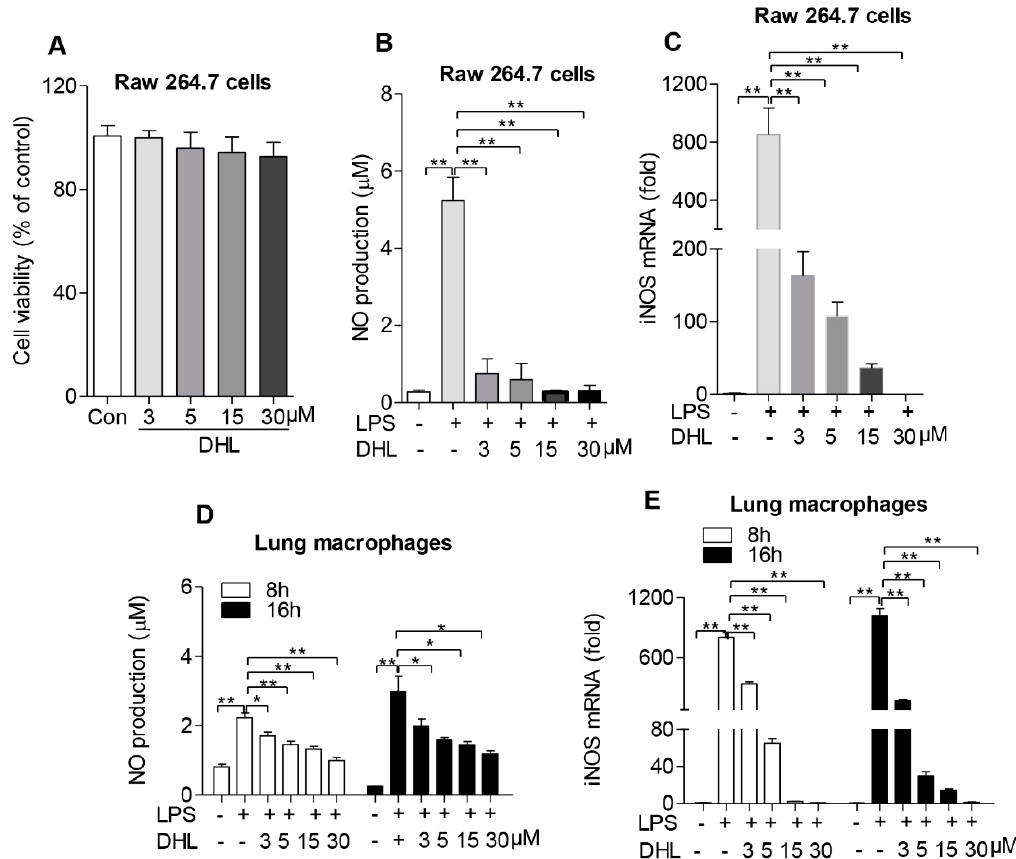
Figure 2. DHL inhibited NO production and iNOS expression in LPS-stimulated macrophages. ( A ) RAW264.7 cells were treated with DHL at 0, 3, 5, 10 and 30 µ mol / L for 48 h, and cell viability was determined by MTT assay. ( B , C ) RAW264.7 cells were pretreated with 0, 3, 5, 10 and 30 µ mol / L DHL for 30 mins followed by stimulation with LPS (100 ng / mL) for 24 h, the supernatant of culture medium was collected for NO detection, and the mRNA levels of iNOS were analyzed by quantitative real-time PCR. Lung macrophages were pretreated with 0, 3, 5, 10 and 30 µ mol / L DHL for 30 min followed by stimulation with LPS (100 ng / mL) for 8 and 16 h, ( D ) The culture supernatants were collected and NO levels detected with a Griess reagent kit; ( E ) Cells were collected to isolate total RNA, and the mRNA levels of iNOS were analyzed by quantitative real-time PCR. The data represent mean ± SEM of three independent experiments, * p < 0.05 and ** p < 0.01.